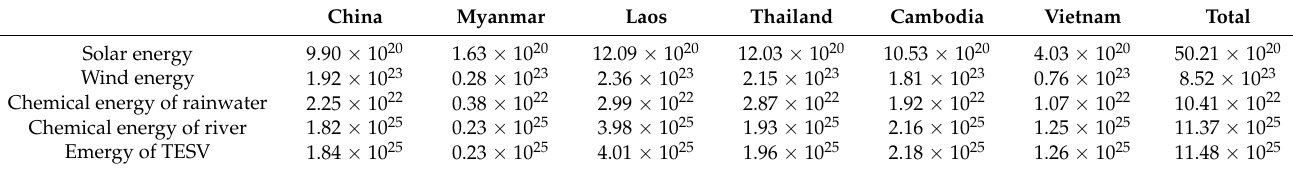
Table 4. Emergy of total ecosystem service value (TESV) for countries in LMRB unit: sej.